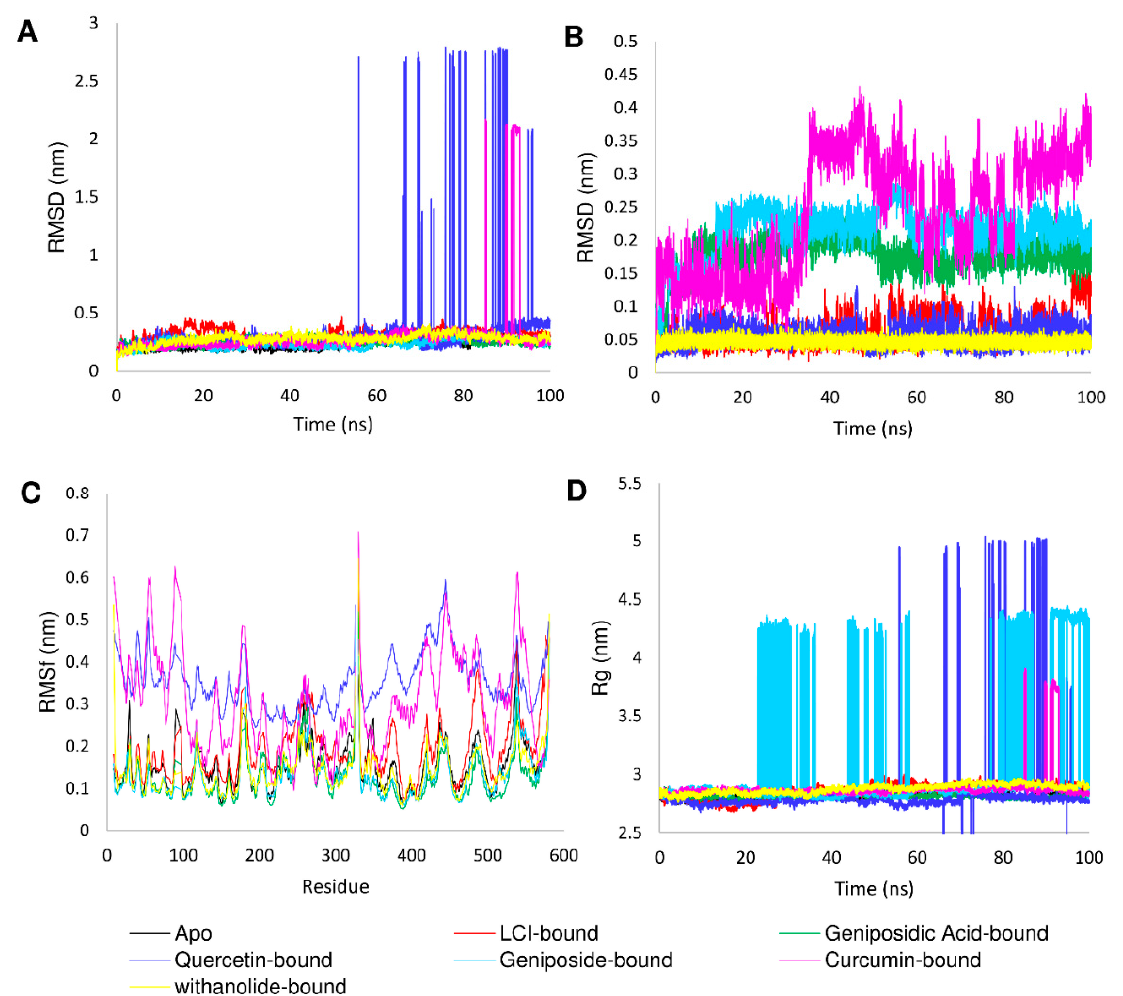
Figure 5. ( A ) RMSD of backbone atoms for apo and holo forms of protein, ( B ) RMSD of ligands atoms, ( C ) RMSF of backbone atoms of apo and holo forms of protein, ( D ) Rg of the protein in apo and holo forms. The CDK9/cyclinT1 apo and holo versions were added to 100 ns MD simulations in an explicit solvated system. Before equilibration for all systems, the protein backbone residues exhibited little variations (apo and holo). LCI-bound, geniposidic-acid-bound, geniposide-bound, and withanolide-bound CDK9/cyclinT1 remained constant during the MD simulation research for the RMSD of the backbone atoms of apo. Curcumin exhibits the most considerable level of variation inside the CDK9/cyclinT1 binding site, according to RMSD measurements. However, it is essential to remember that withanolide had remarkably steady dynamic behavior inside the binding site of CDK9/cyclinT1. The Rg plot showed that the CDK9/cyclinT1 bound to withanolide, geniposidic acid, and LCI attained tighter packing.